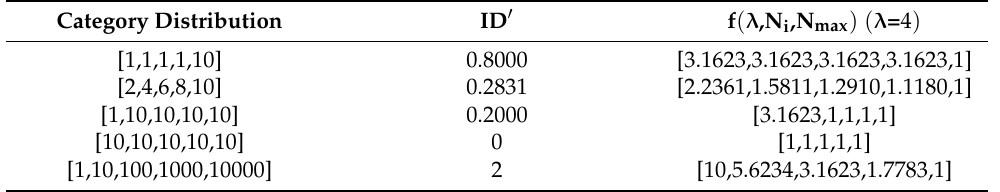
Table 2. Imbalance of different category distributions.